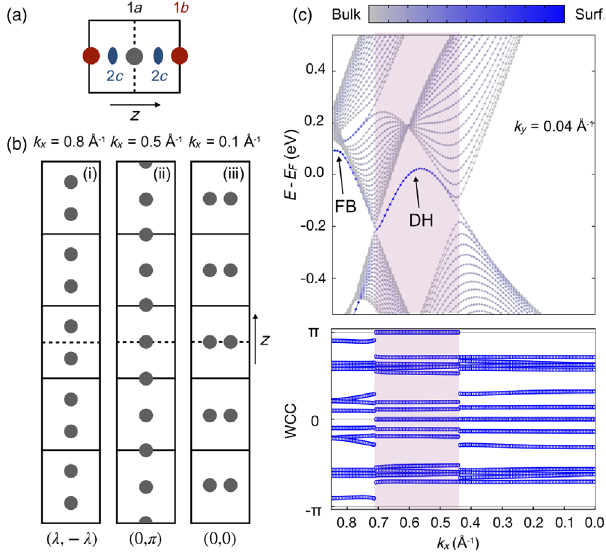
¯ M FIG. 3. (a) WCC positions constrained by z in a single unit ¯ M cell. (b) Three different z symmetric slabs with different configurations of WCCs corresponding to the three different configurations found in ZrSiTe [compare to panel (c)]: (i) WCC located at position 2 c , (ii) one WCC located at position 1 a and one at 1 b , (iii) two WCCs located at position 1 a . Only two WCCs are shown for the sake of clarity. (c) Surface band structure calculated from a Wannier interpolation and WCCs calculated along the same k path. Bulk states are depicted in gray, while surface states are colored blue. DH surface states in regions with a π -Berry phase (shaded region) are of topological origin, while the other surface states (FB) close to E F derive from the local ¯ M breaking of the nonsymmorphic symmetry z at the surface